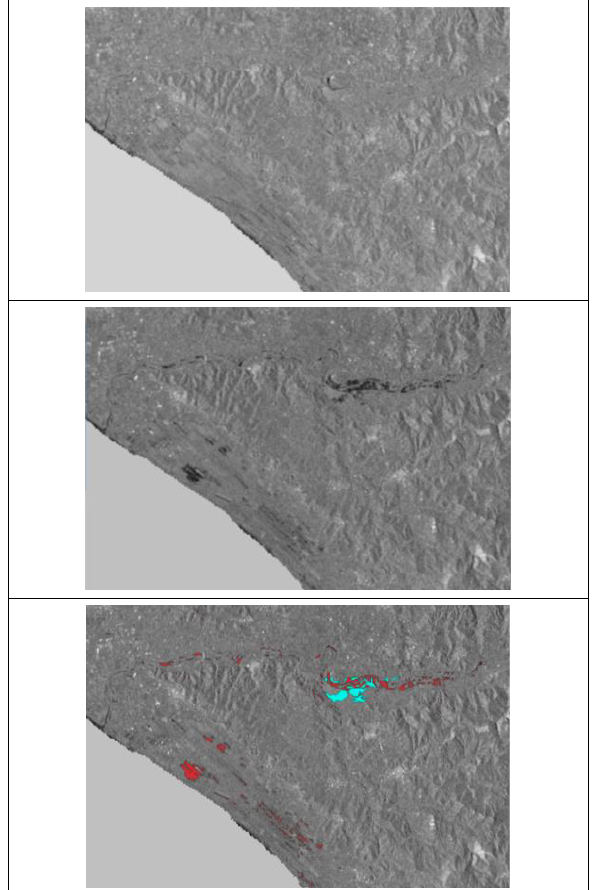
Figure 7. Sentinel-1 pre-event (upper), post-event (middle) and Copernicus-EMS vector output in cyan (lower) and our approach’s output in red (lower) over the area of